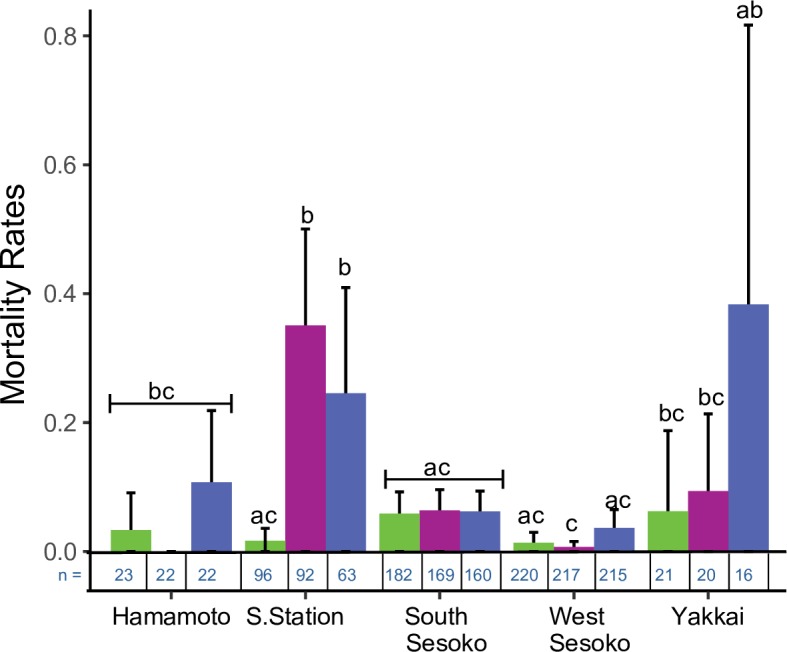
Spatial variations in mortality at different time periods.Letters represent significantly different groups. Error bars denote standard deviation. Sample size per treatment is below the graphs in blue text. t1: time period 1; tbl: 1 month after bleaching; t2: 6 months after bleaching. Different morphology categories are pooled by site.